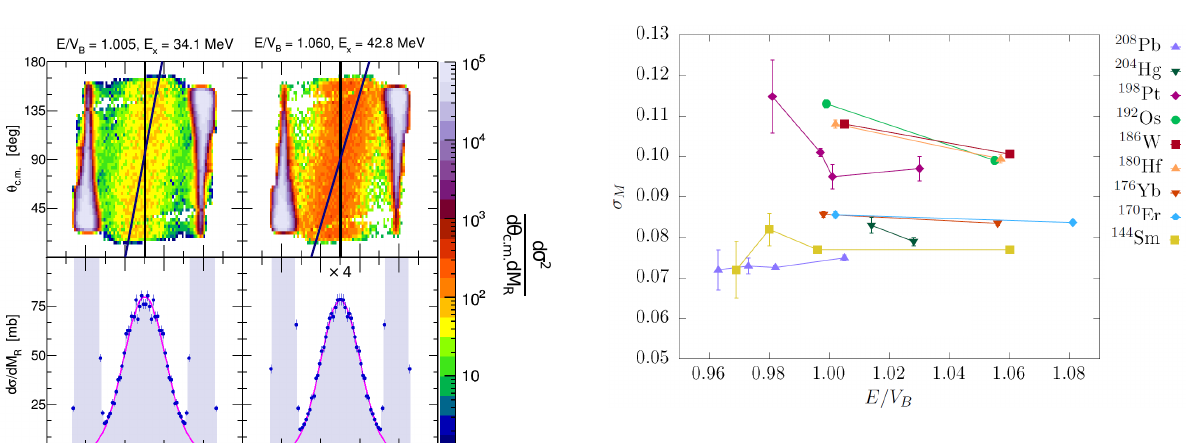
Figure 2. The measured mass widths, σ M , presented as a func- tion of the centre-of-mass energy with respect to the capture bar- rier for all reactions measured in this work. The error bars are determined from the calculated uncertainty in the standard devi- ations of the Gaussian fits for each reaction. The lines are used to guide the eye between each data point to highlight the general trends for each reaction. The two spherical targets, 144 Sm and 208 Pb, show a significantly di ff erent trend to the all other targets, with an increase in σ M with increasing energy being